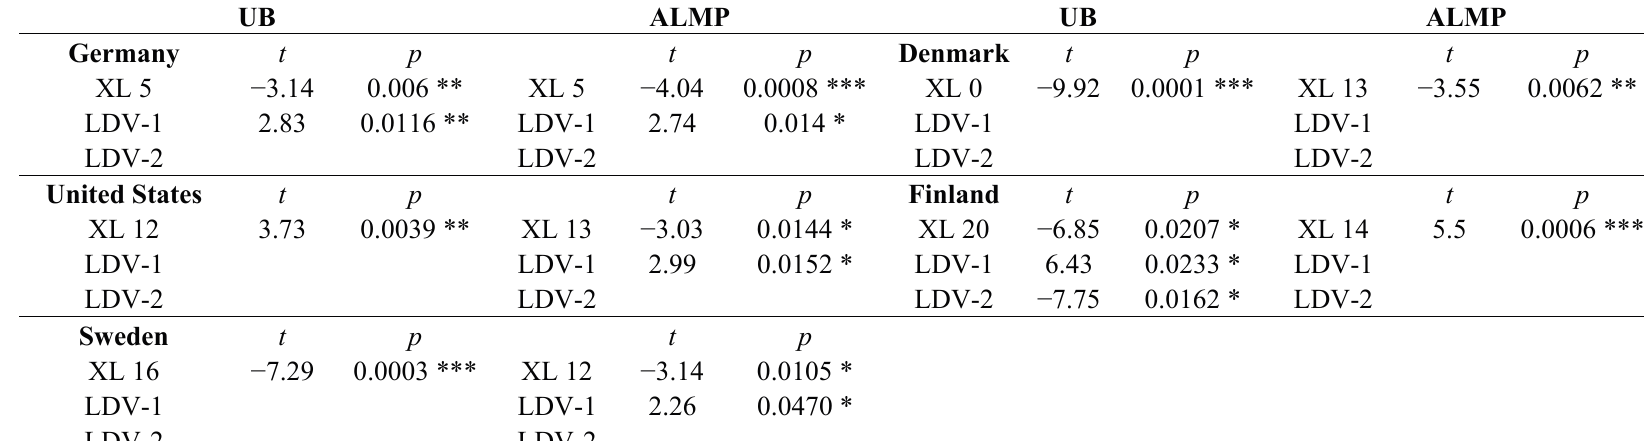
Table 2. The countries where capital flow was more significant than institutional stickiness.